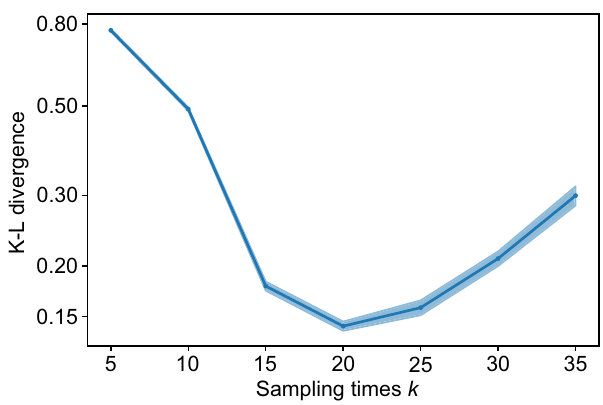
FIG. 10. The K-L divergence from a Porter-Thomas distribu- tion for random Hamiltonian evolution. The K-L divergence is plotted as a function of the total number of sampling times, k . A minimum of 0.142 is reached at k = 20. The shaded region represents the standard deviation computed over 30 runs of the simulation for each value of k .